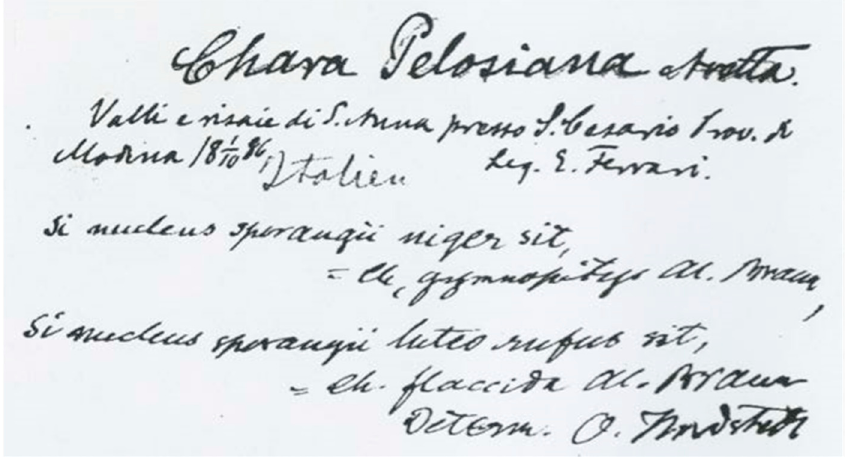
Figure 4. Label of the Oslo lectotype of Chara pelosiana with Nordstedt’s observation; from